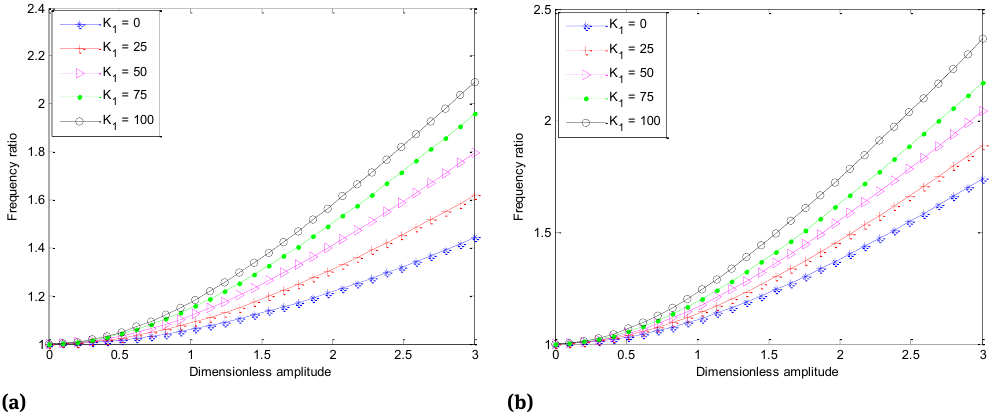
Figure 7: (a) Effects of dimensionless quadratic elastic medium stiffness on the frequency ratio for simply supported nanobeam (b) Effects of dimensionless quadratic elastic medium stiffness on the frequency ratio for clamped-clamped supported nanobeam